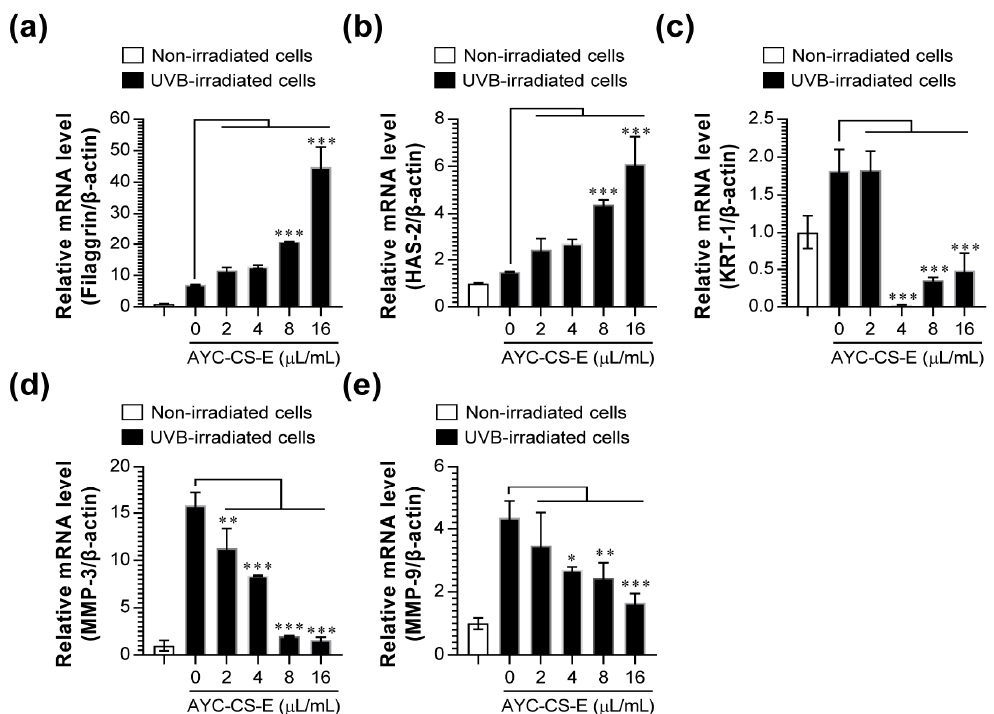
Figure 4. Effect of AYC-CS-E treatment on photoaging-related factor expression of UVB-irradiated HaCaT cells. ( a – e ) HaCaT cells were treated with various concentrations (2, 4, 8, or 16 µ L/mL) of AYC-CS-E (30 mg/mL) for 24 h after being exposed to 8 mJ/cm 2 UVB irradiation. Cells were collected, total RNA was extracted, and cDNA was synthesized for quantitative real-time polymerase chain reaction (qRT-PCR), as described in the Materials and Methods section. The mRNA expression of the photoaging-related factors (Filaggrin ( a ), HAS-2 ( b ), KRT-1 ( c ), MMP-3 ( d ), and MMP-9 ( e )) were analyzed by a real-time PCR machine. HAS-2: hyaluronic acid synthase 2; KRT-1: keratin 1. Relative mRNA expression levels were normalized to β -actin. All bar graphs show the means ± standard deviation (SD) of 3 samples. One representative plot out of three independent experiments is shown. * p < 0.05, ** p < 0.01, or *** p < 0.001.